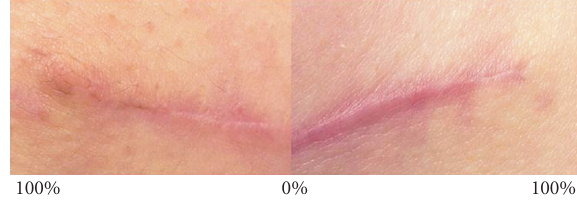
Figure 3: The global scar comparison scale. The photographic records of each scar are placed side by side over a double- ended visual analogue scale which represents percentage scar improvement. The 0% rating equates to an assessors opinion that there is no detectible di ff erence between the two scars; whereas the 100% rating on either side means that that particular scar is so improved that it is imperceptible from the surrounding normal